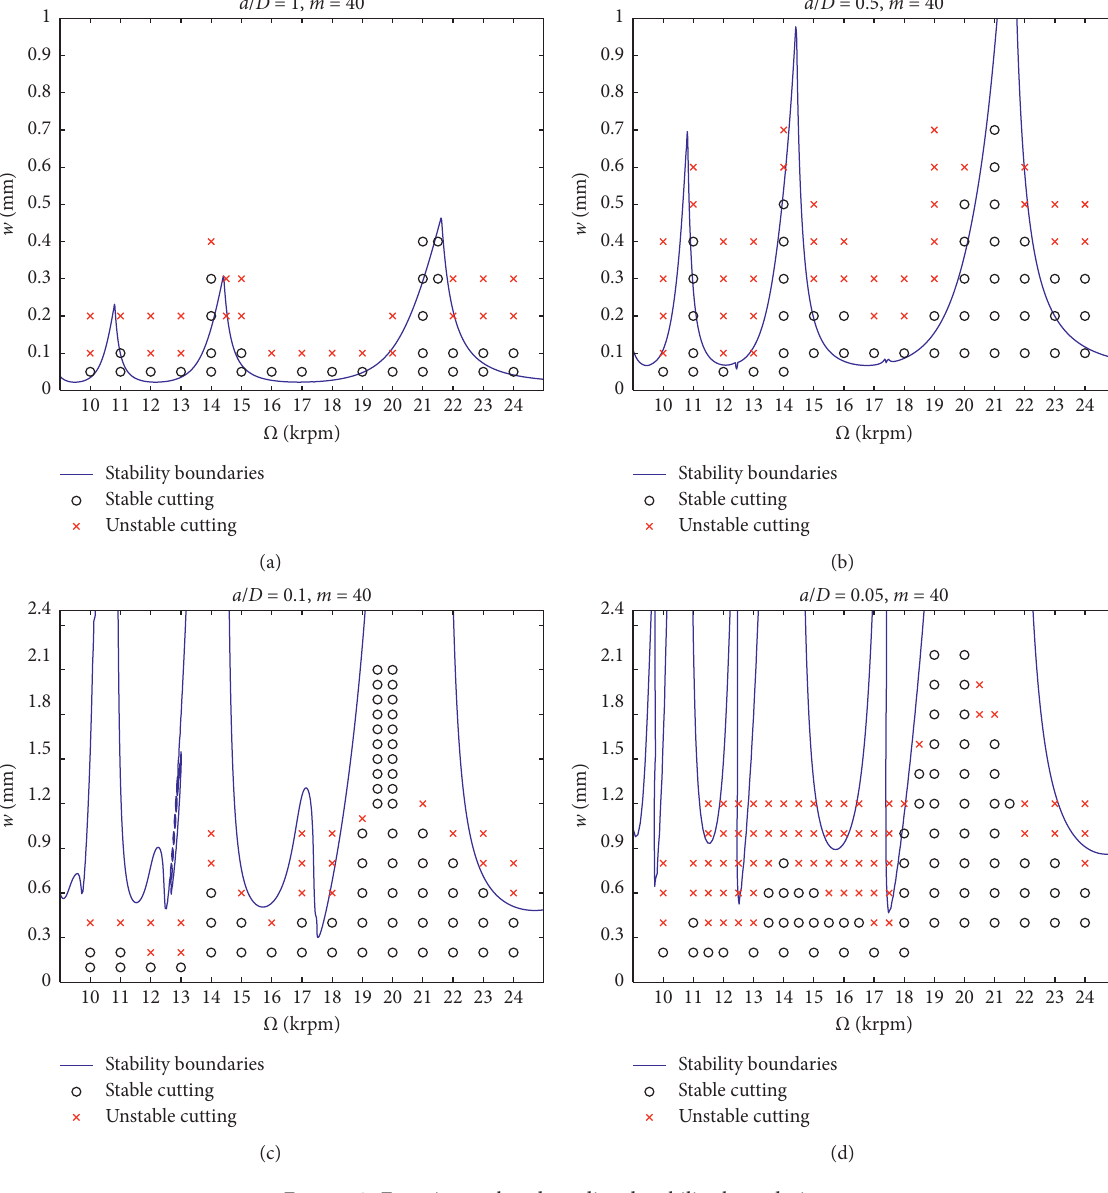
Figure 3: Experimental and predicted stability